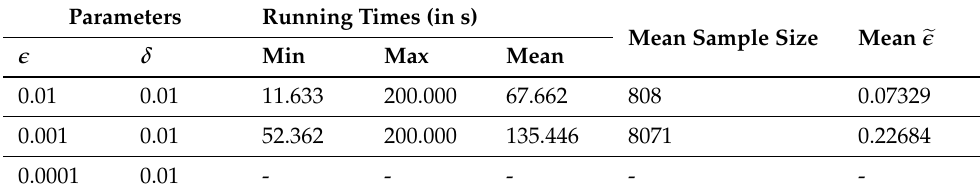
Table 7. Cruise controller: Automaton